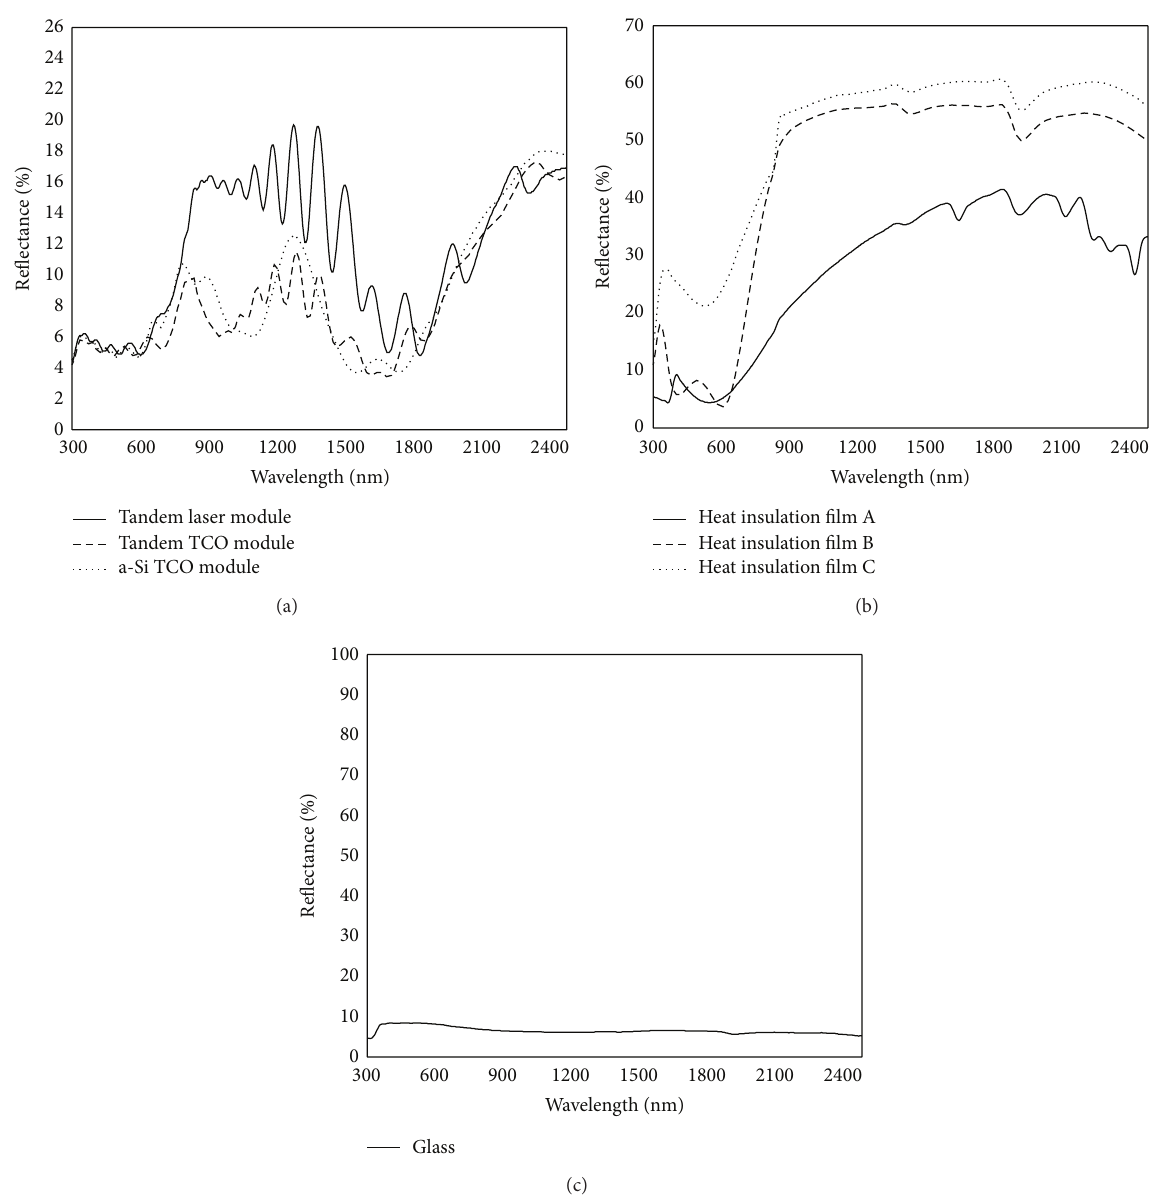
Figure 5: Reflectance spectra of each component: (a) semitransparent PV modules, (b) heat insulation films, and (c) rear